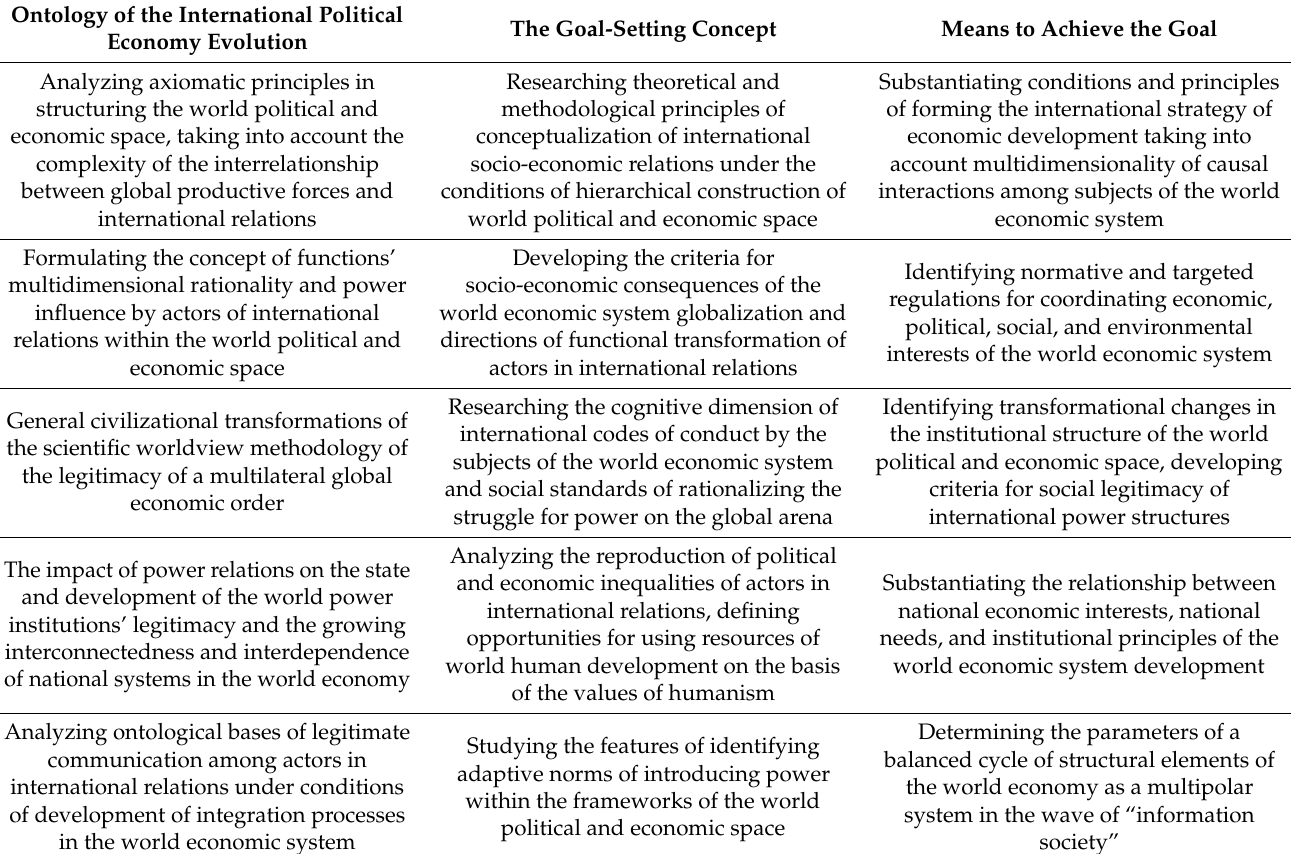
Table 1. Theoretical and methodological principles of the international political economy